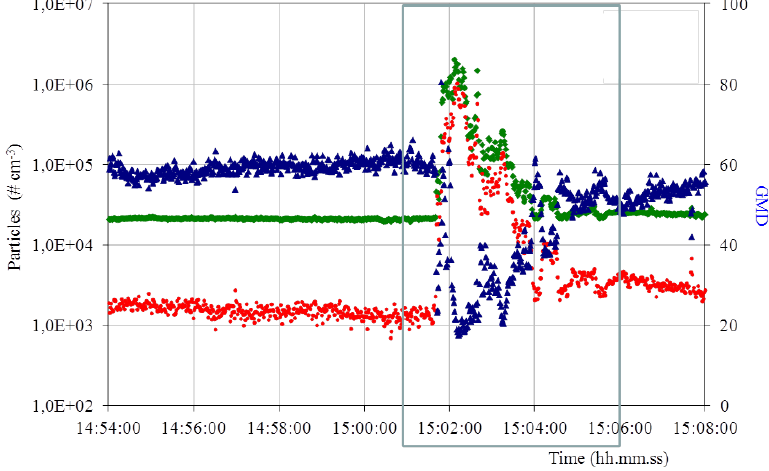
Figure 4. Submicronic particles (5.6–16 nm red circles; 5.6–560 green diamonds) and geometric mean diameter (blue triangles) during a Metal Inert Gas (MIG)